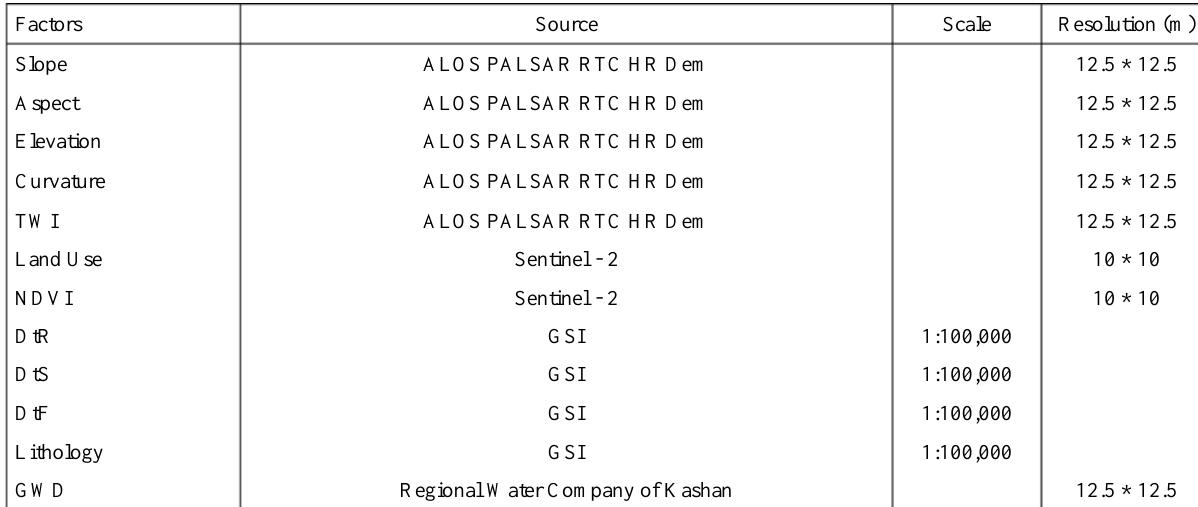
Table 1. The details of the input influentioal